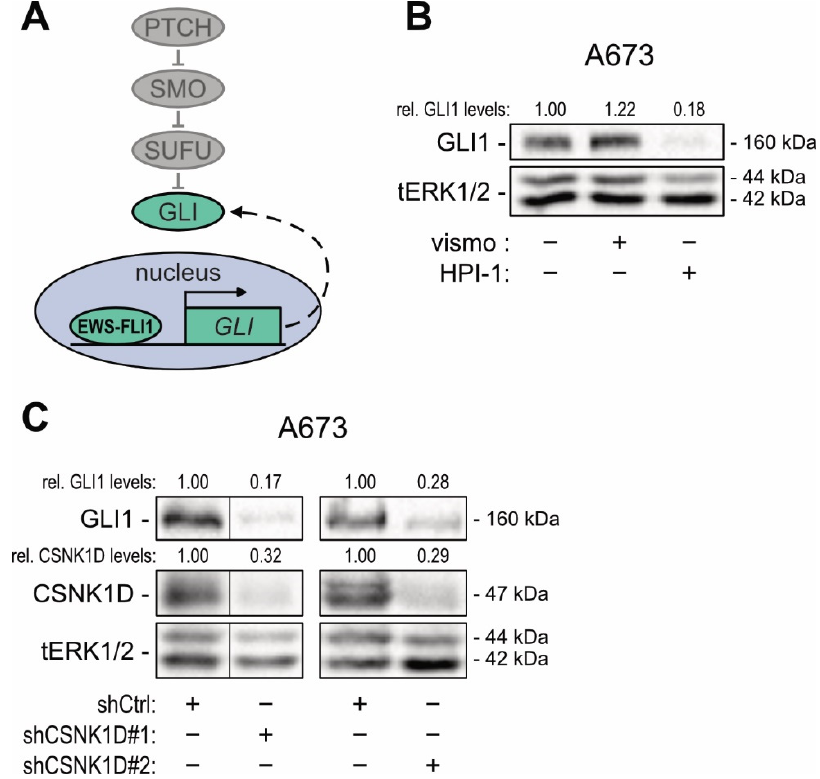
Figure 2. RNAi-mediated inhibition of CSNK1D interferes with oncogenic HH–GLI signaling in SMOi resistant Ewing sarcoma cells. ( A ) Simplified schematic illustration of non-canonical, SMO- independent HH–GLI signaling in Ewing sarcoma with EWS–FLI1-driven transcription of GLI1 . ( B ) Representative Western blot analysis of GLI1 in A673 cells treated with vismodegib [1 µM] or HPI-1 [20 µM]. ( C ) Representative Western blot analysis of GLI1 in A673 cells lentivirally transduced with shCSNK1D (#1, #2) or control shRNA (shCtrl). Relative quantification of Western blot bands was conducted via densitometric image analysis using Image Lab 5.0 software (Bio-Rad, Vienna, Austria). Relative protein levels normalized to the loading control tERK and to the Ctrl sample are shown above each protein band.